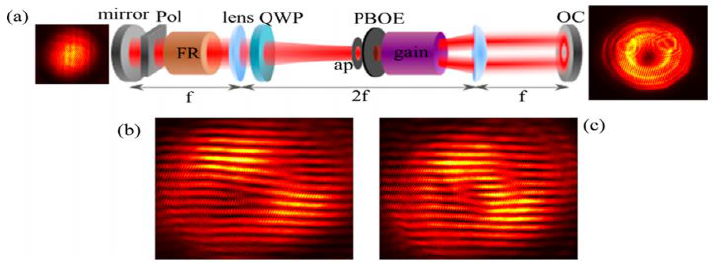
Figure 16. ( a ) Diagrammatic experimental setup of the modified degenerate laser. Self-interference patterns of vortex beam modes, including ( b , c ) the topological charges l = ± 1, respectively (Adapted from an open-access source Ref. [108]).